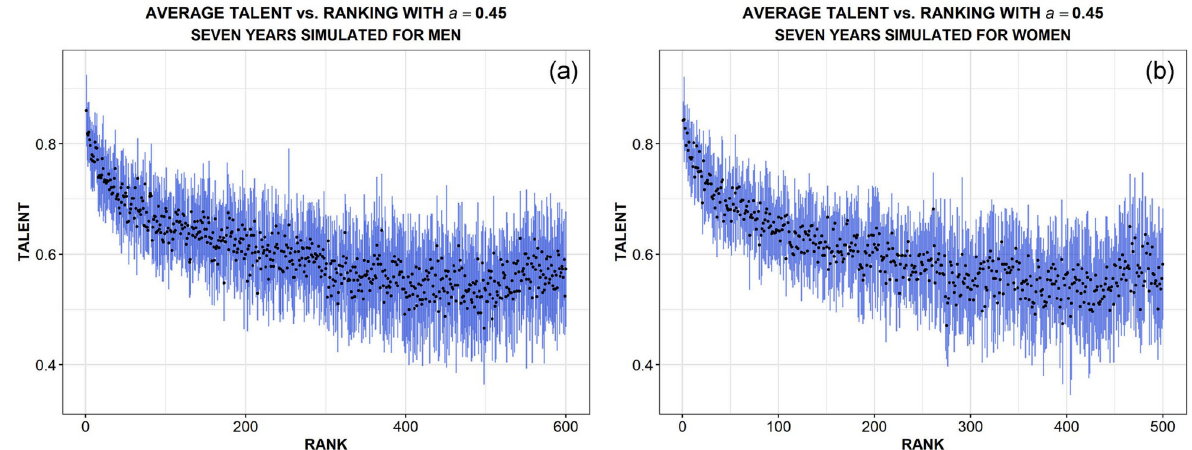
Fig 8. Distribution of talent as a function of fencers’ ranking in simulations, for men and women respectively panel (a) and (b). Mean values from the seventh year of ten runs are shown, error bars (blue) representing their standard deviation.